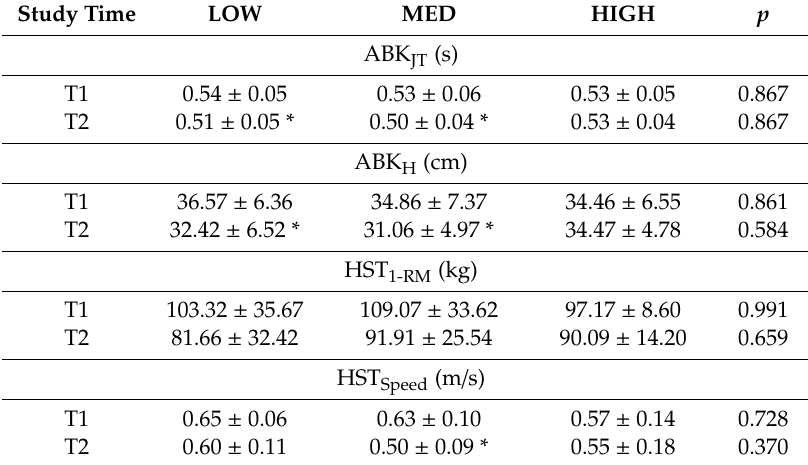
Data are indicated as mean ± standard deviation. p : Statistical di ff erences among groups in each time point by Kruskal–Wallis test. * Significant di ff erences ( p < 0.05) between time points (T1 vs. T2) within the same group as determined by Wilcoxon signed rank